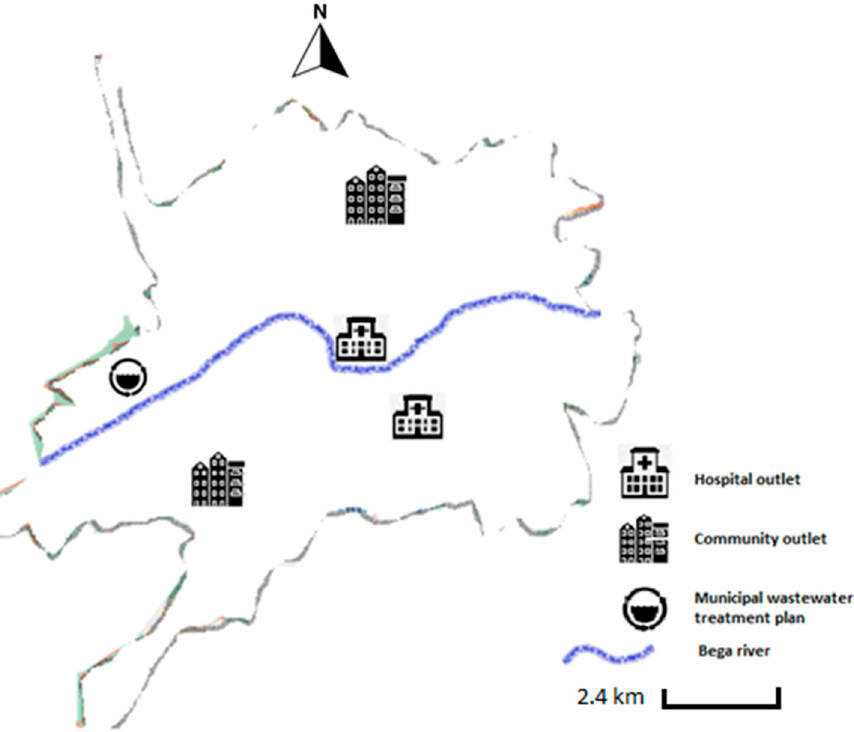
Figure 1. Wastewater sampling sites and their approximate geographical locations in Timisoara city.